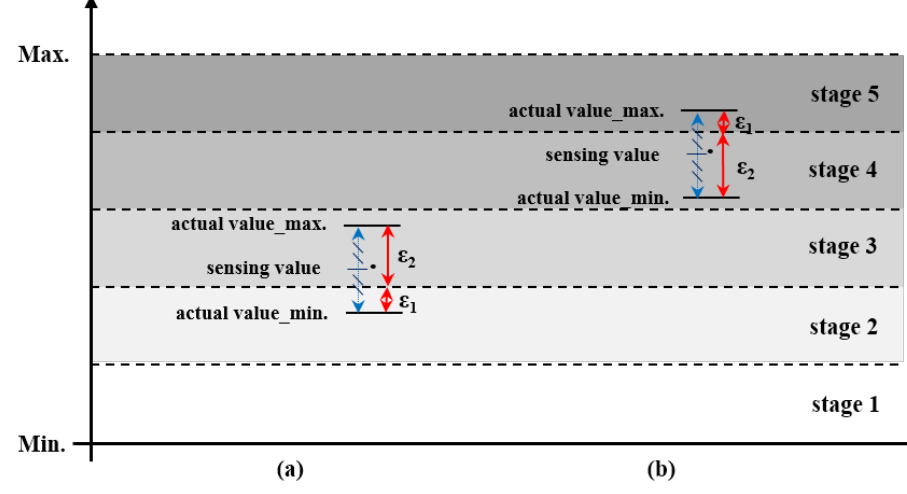
Figure 6. Examples of ( a ) a higher operational stage decision and ( b ) a lower operational stage